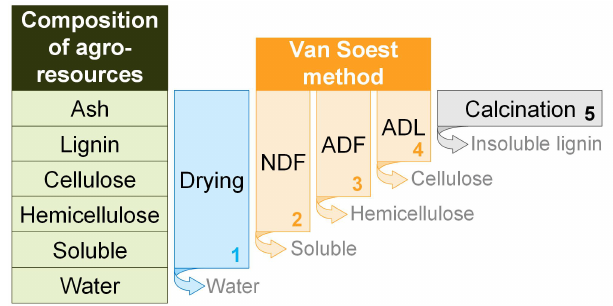
Figure 4. Synthetic sketch of the Van Soest method allowing assay of the biomass composition [20]. ADF: acid detergent fiber; ADL: acid detergent lignin; NDF: neutral detergent